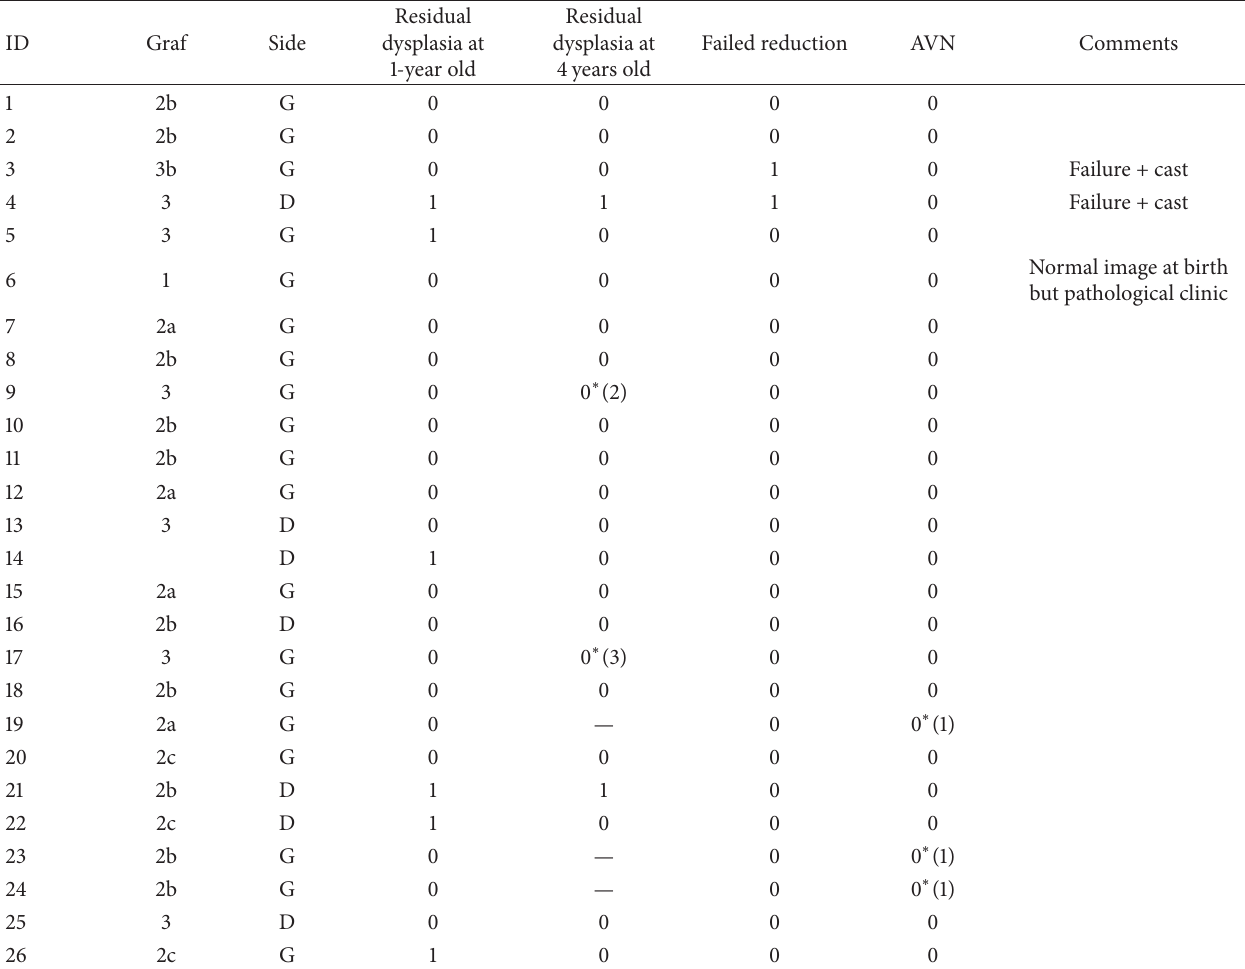
Table 3: Values of unilateral dysplasia.